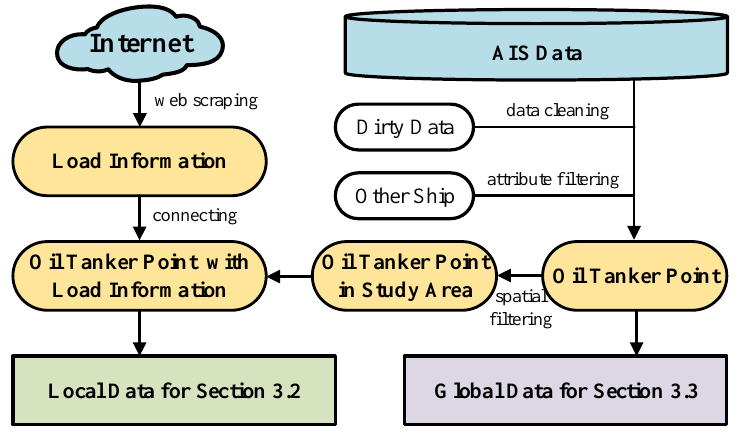
Figure 3. Data preprocessing.